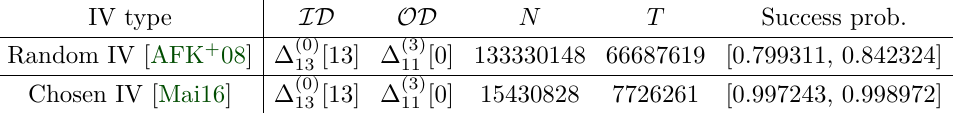
Table 7: More accurate success probabilities of the attacks on 7-round ChaCha256